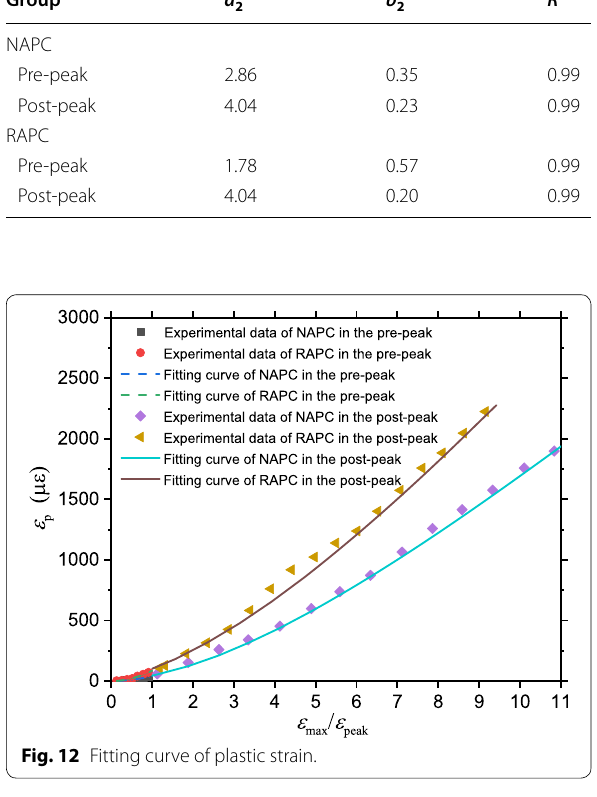
Fig. 12 Fitting curve of plastic strain.